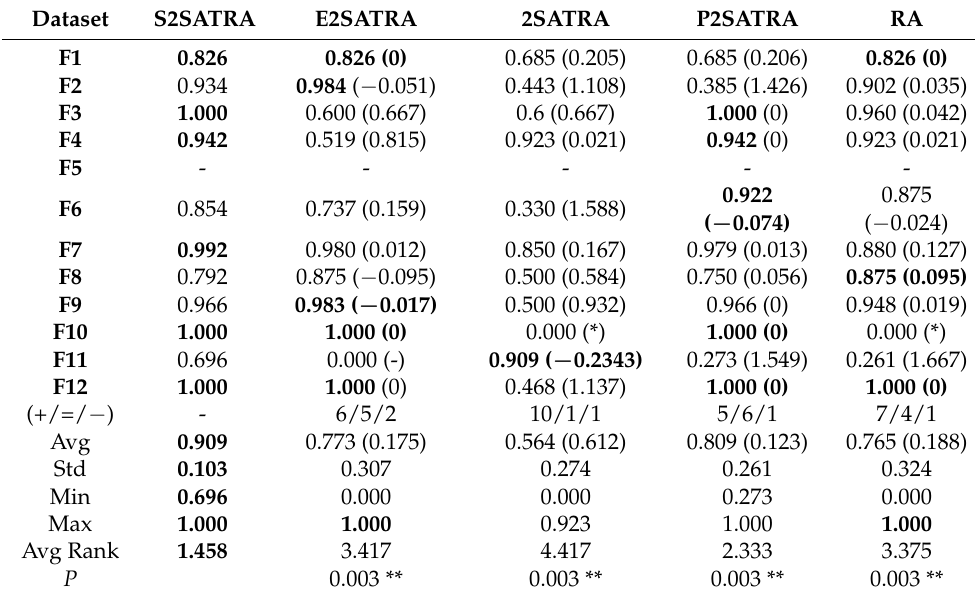
Figure 15. Accuracy for all the logic mining models. Table 11. Precision ( Pr ) for all models. The bracket indicates the ratio of improvement and * indicates division by zero. A negative ratio implies the method outperform the proposed method. P is obtained from the paired Wilcoxon rank test and ** indicates the model with significant inferiority compared to the superiority